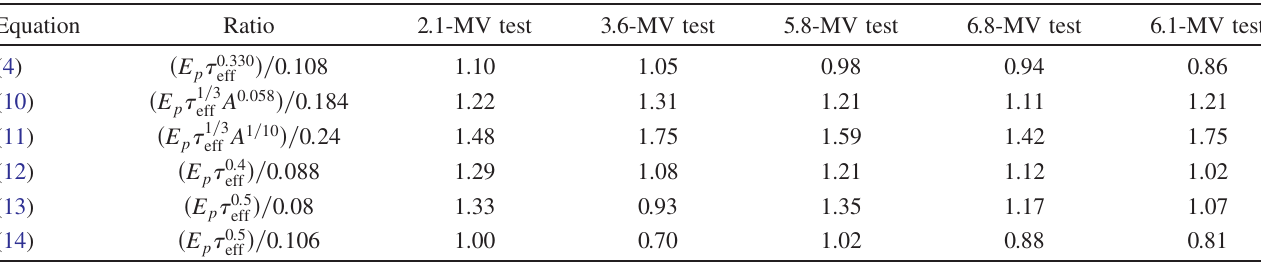
TABLE II. Comparison of the results summarized by Table I with the predictions of Eqs. (4) and (10)–(14). The second column lists ratios obtained from the equations; columns 3–7 list values of the ratios for the 2.1-, 3.6-, 5.8-, 6.8-, and 6.1-MV tests, respectively. The values listed in the first five rows suggest Eqs. (10)–(13) are more conservative—but less accurate—than Eq. (4). The first and last rows suggest Eq. (14) is less conservative than Eq. (4); however, Eq. (9) [from which Eq. (14) is derived] is significantly less consistent than Eq. (3) with other measurements performed at megavolt voltages (Ref. [20], Table II). Equation Ratio